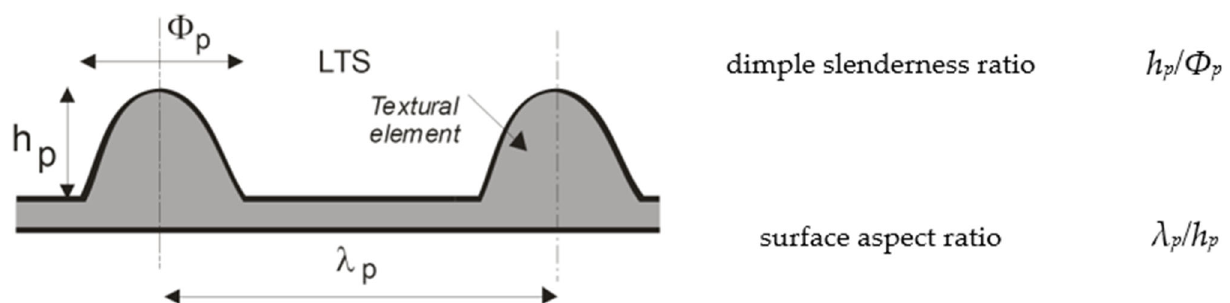
Figure 5. Definition of the primitive geometrical attributes for a textured surface, where h p — is the height of the texture element, Φ p — is the texture element base diameter and λ p — is the centerline ‐ to ‐ centerline spacing between texture elements [62].